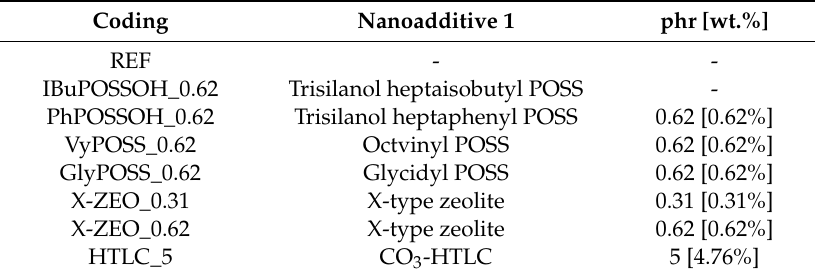
Table 2. Formulations with a single nanoadditive.